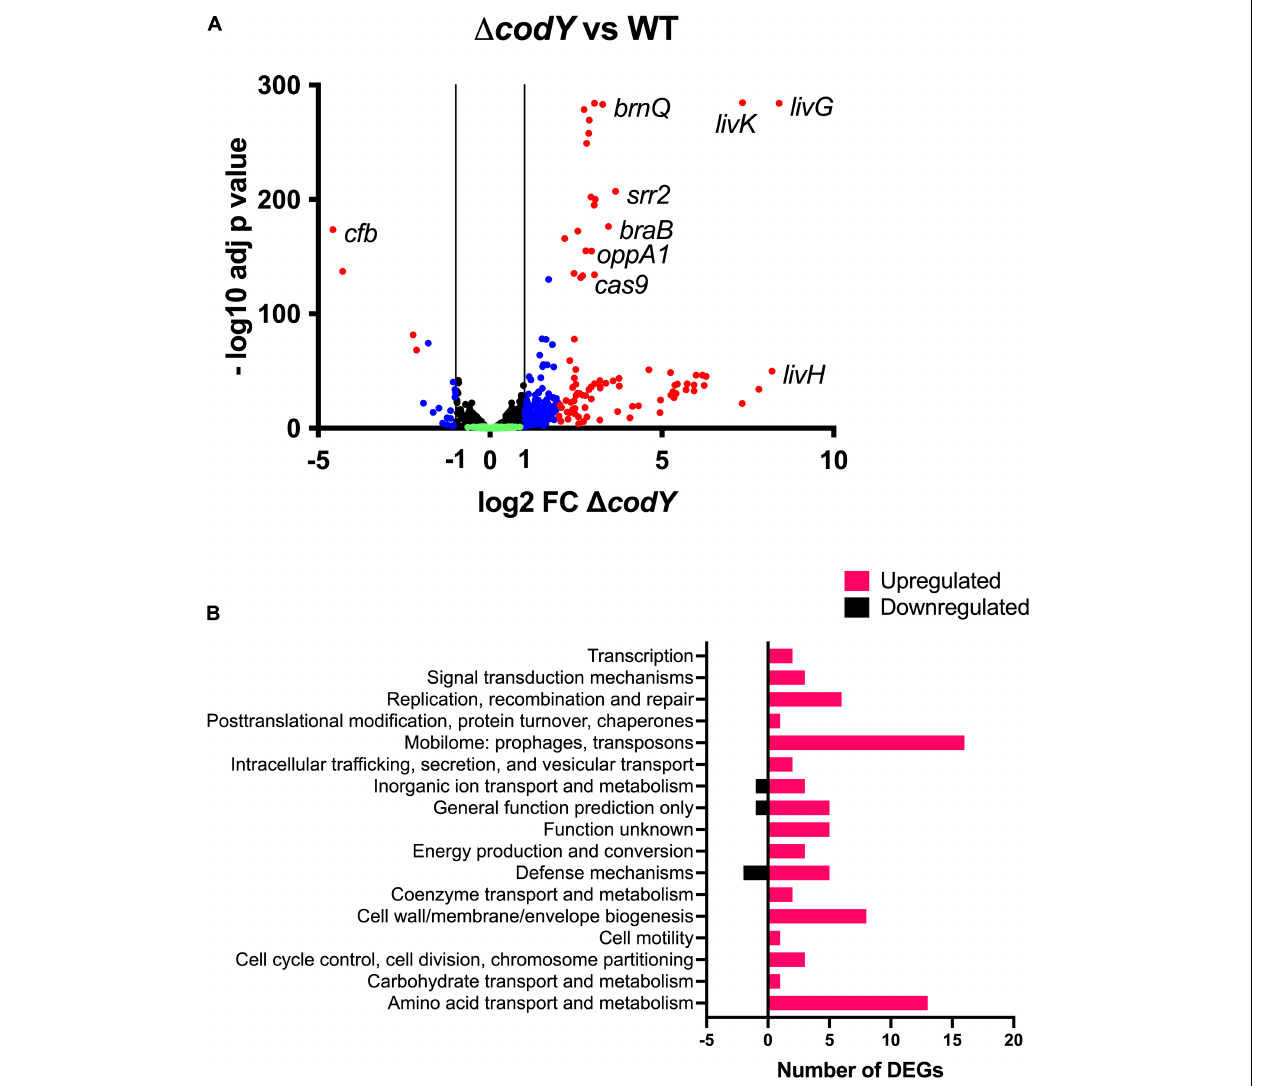
FIGURE 5 | (A) Volcano plot of the (cid:49) codY transcriptome at mid-exponential phase in THY. Each dot represents a gene with its RNA-seq fold change and adjusted p -value calculated from four independent replicates. Genes showing a significant differential expression in the (cid:49) codY strain (adjusted p -value < 0.05) are represented in blue (–2 ≤ log2FC ≤ –1 or 1 ≤ log2FC ≤ 2) and red (log2FC < –2 or log2FC > 2) according to their fold change relative to the WT strain. Black dots represent genes whose expression is not affected by codY deletion (–1 < log2FC < 1; adjusted p -value < 0.05). Green dots correspond to non-significant (adjusted p -value > 0.05) differentially transcribed genes. (B) COGs associated to downregulated and upregulated